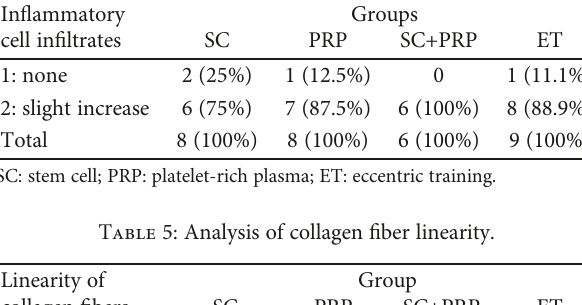
Table 2: Results of pairwise statistical analyses of the di ff erences between the groups with regard to the biomechanical variables.